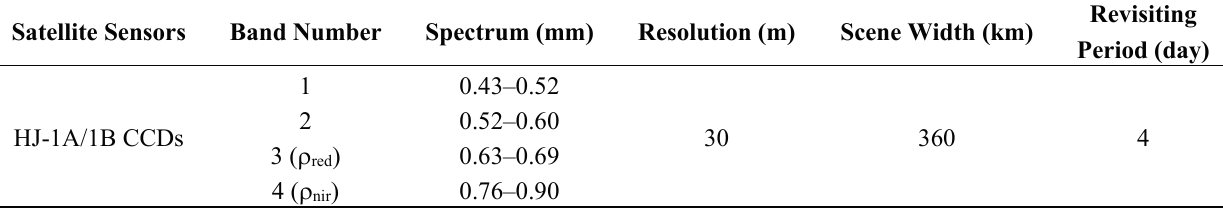
Table 3. The main specifications of the HJ-1A/1B satellites and the Charge Couple Device (CCD)